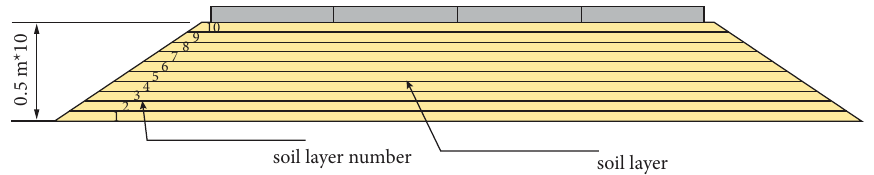
Figure 14: Schematic diagram of soil layer division and numbering.